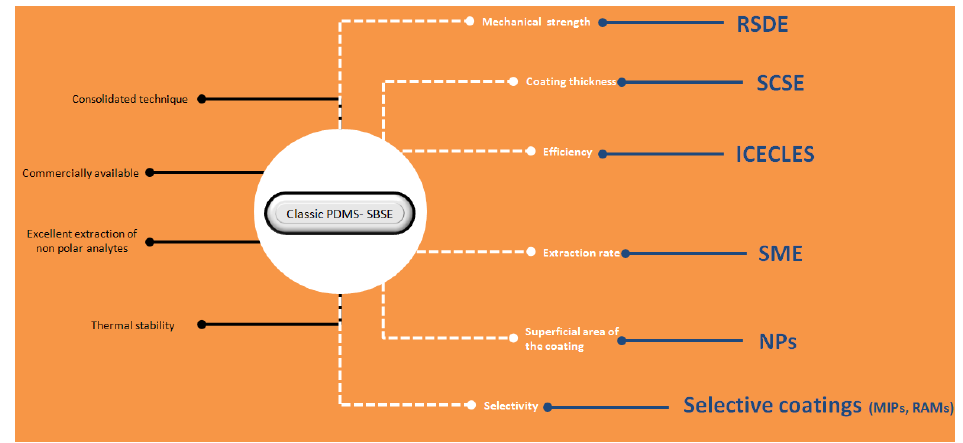
Figure 12. Brief summary of the techniques described in the article. The advantages of classic polydimethylsiloxane (PDMS) based stir bar sorptive extraction (SBSE) are shown in black letters, the characteristics that may be compromised in several applications are indicated in white characters, and the techniques/material that can overcome these limitations are presented in blue. For further details, read the text.